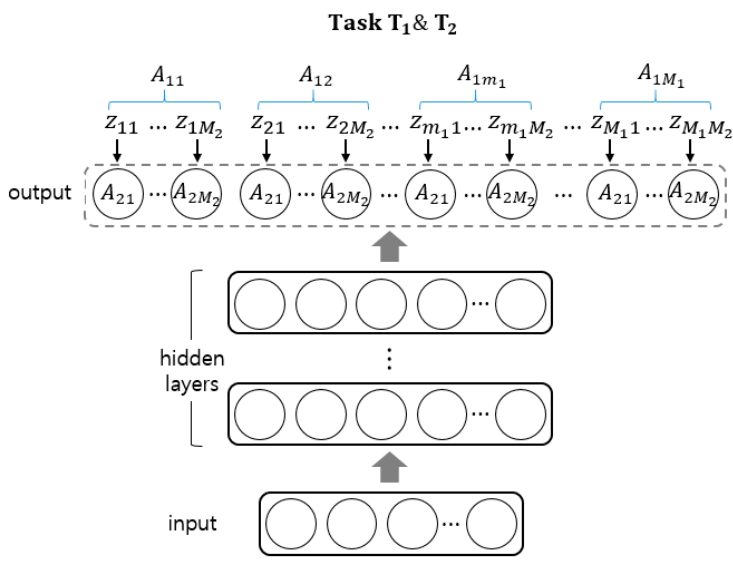
Figure 3. Network for multi-task learning for joint random vector output.